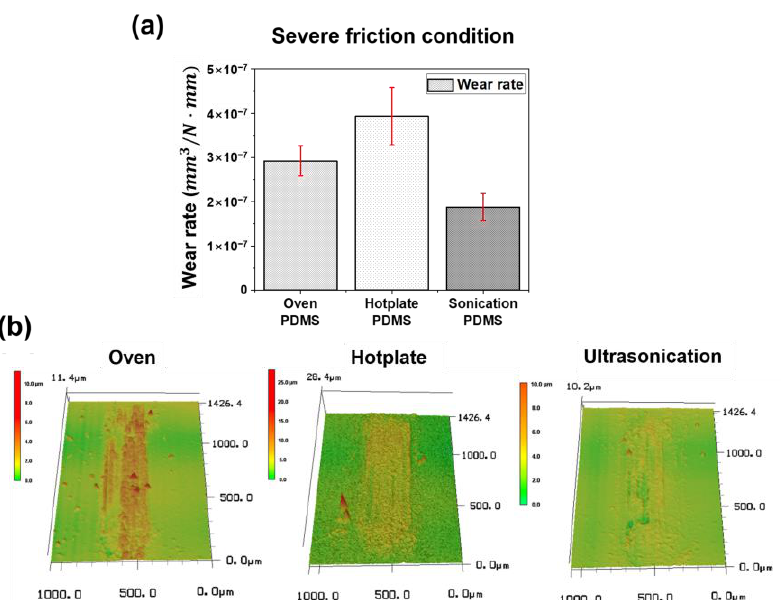
Figure 6. ( a ) Average wear rates, and ( b ) 3D laser scanning confocal microscope images of the wear tracks of the PDMS thin films during different curing methods after sliding test under 1 MPa contact pressure during 10,000 sliding cycles.